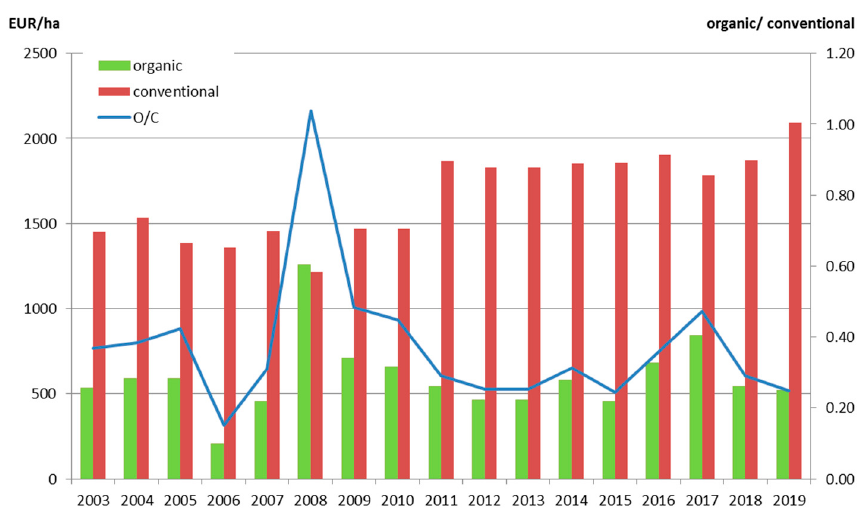
Figure 3. Agriculture production per one hectare in non-ANC (non - Areas with Natural Con- straints). (Source: [38], authors’